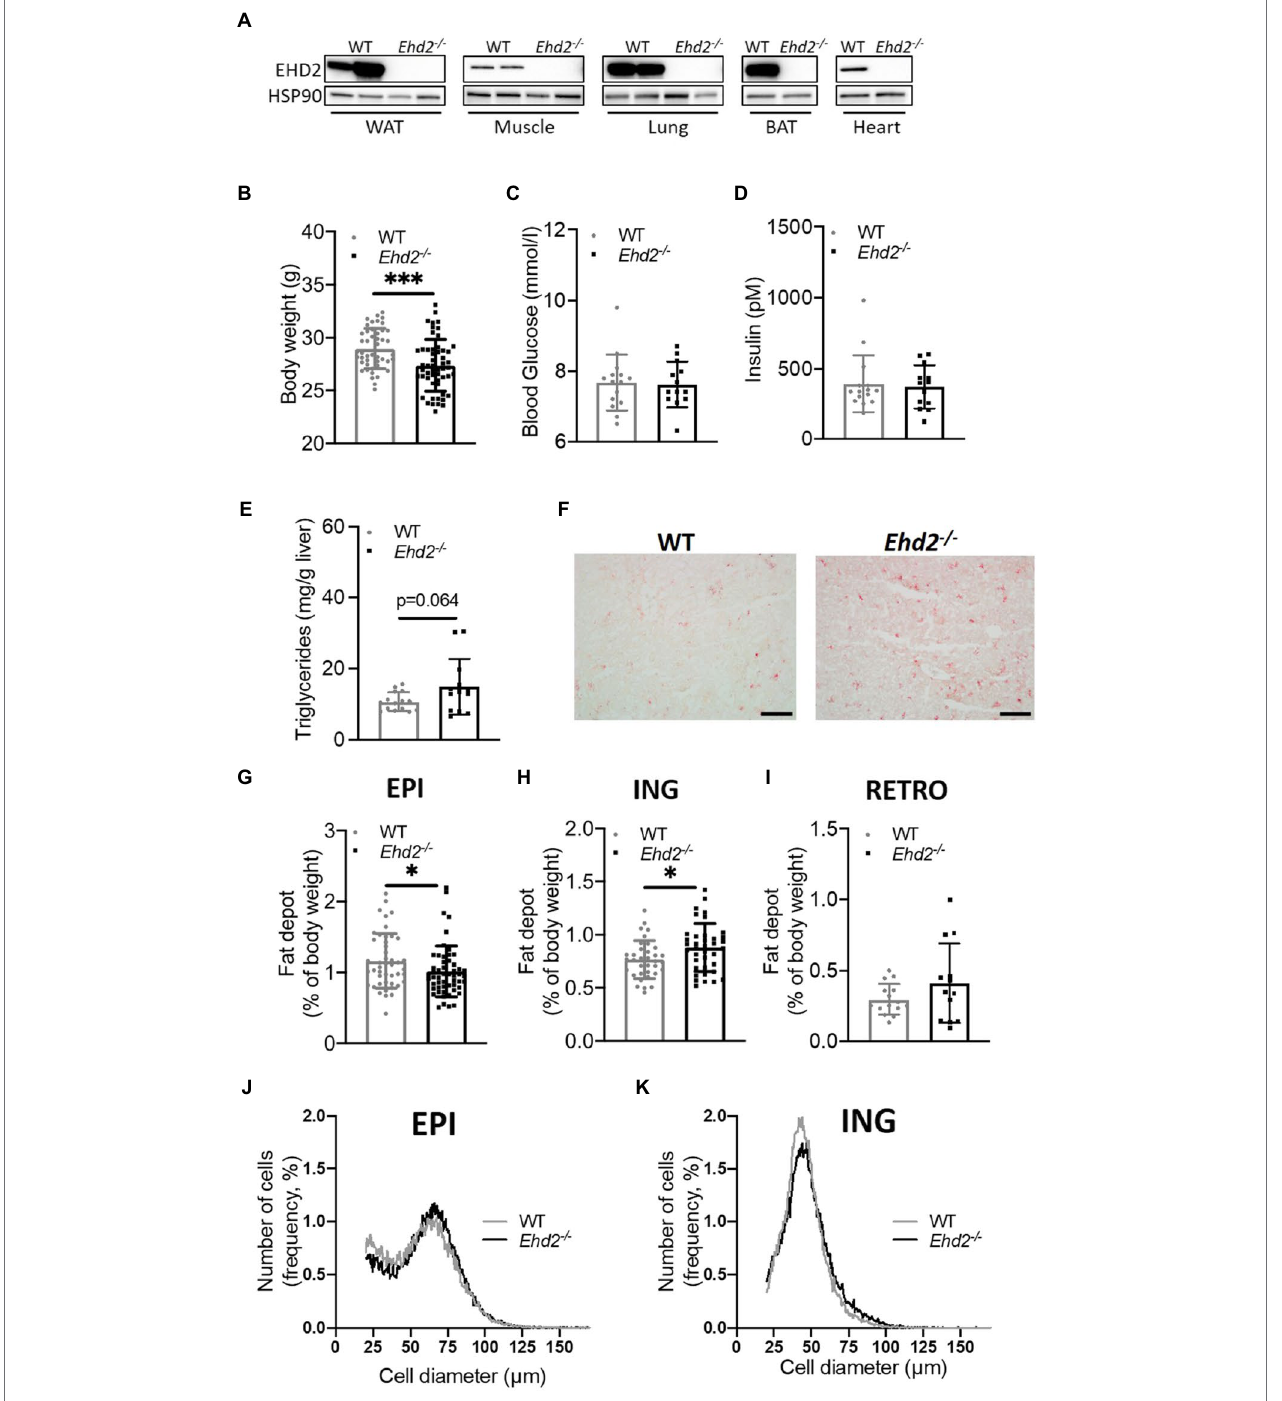
FIGURE 1 | Adipose tissue distribution and adipocyte sizes comparing Ehd2 − / − and WT mice. (A) Western blot analysis illustrating expression of EH domain- containing 2 (EHD2) in different tissues; white adipose tissue (WAT), skeletal muscle, lung, brown adipose tissue (BAT), and heart from Ehd2 − / − and WT mice. Comparison of WT and Ehd2 − / − mice fed chow-diet, showing (B) body weight (BW; n = 46–54 animals/group), (C) blood glucose (mmol/L; n = 13–15 animals/group), and (D) serum insulin (pM; n = 13–15 animals/group). (E) Liver triglycerides (mg/g liver; n = 13–15 animals/group), and (F) illustrated by Oil-Red-O-staining, scale bar = 100 μ m. Adipose tissue depots weights; (G) epididymal (EPI; n = 46–54 animals/group), (H) inguinal (ING; n = 35–38 animals/group), and (I) retroperitoneal (RETRO; 13–15 animals/group). (J,K) Adipose cell size distribution of EPI and ING tissue depots analyzed using coulter counter, 6,000 counts/sample, each sample run in duplicate, data displayed as average from n = 3 samples/group. Data in (B–E,G–I) are presented as mean ± SD, and * p < 0.05 and *** p < 0.001 were calculated using unpaired two-tailed Student’s t